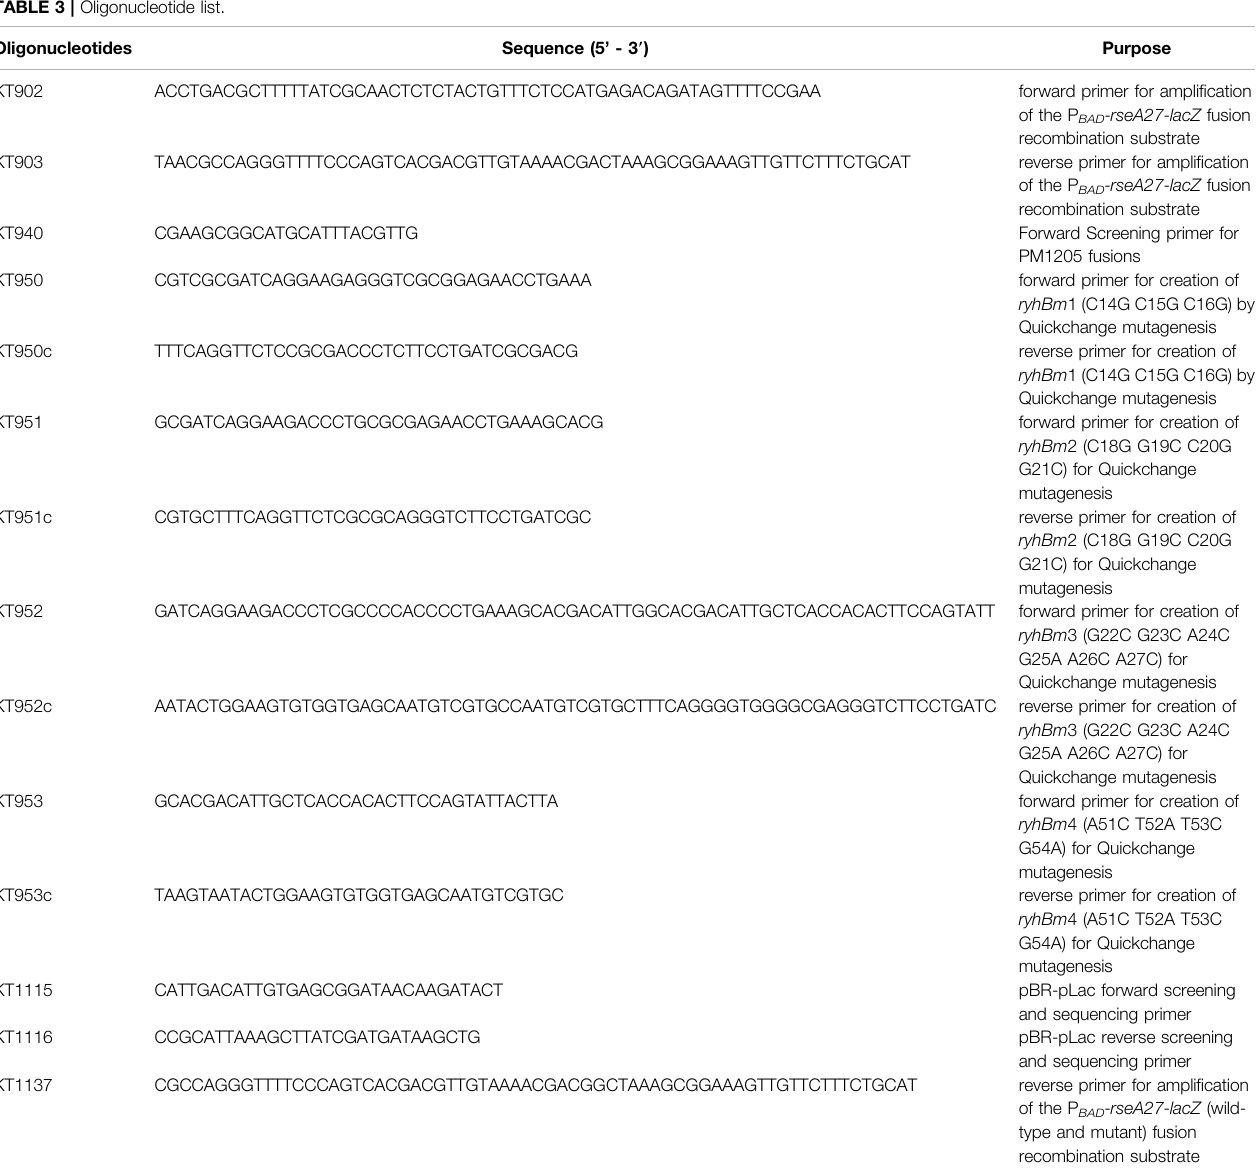
TABLE 3 | Oligonucleotide